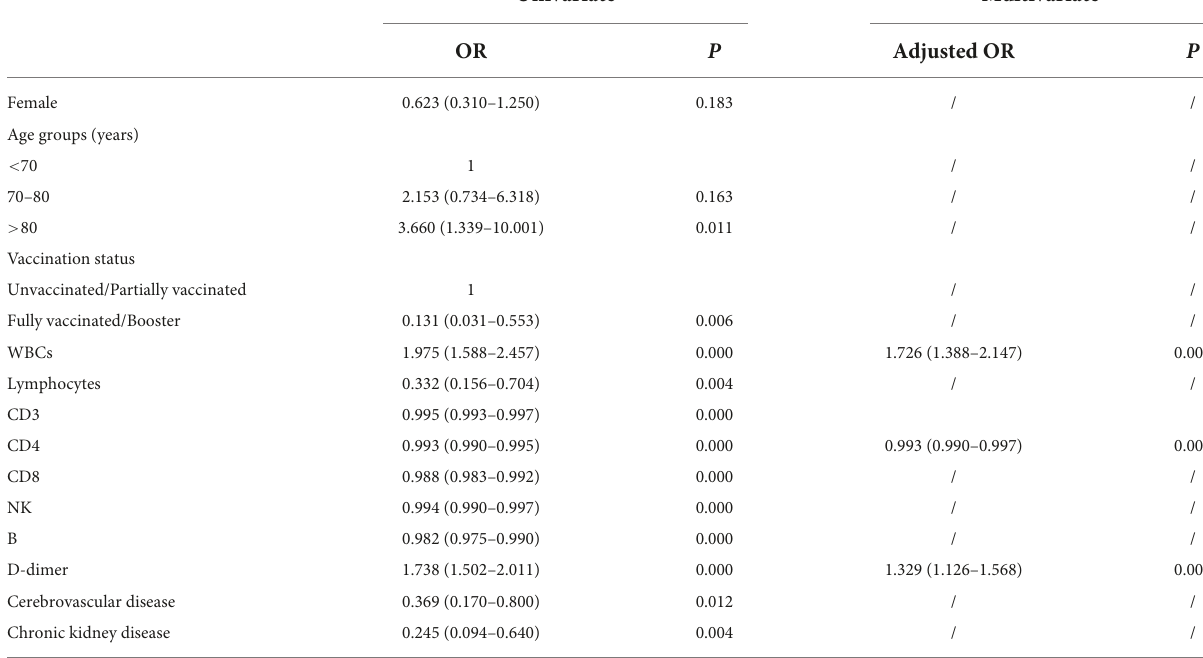
TABLE 2 Risk factors for progressing to severe/critical disease among geriatric